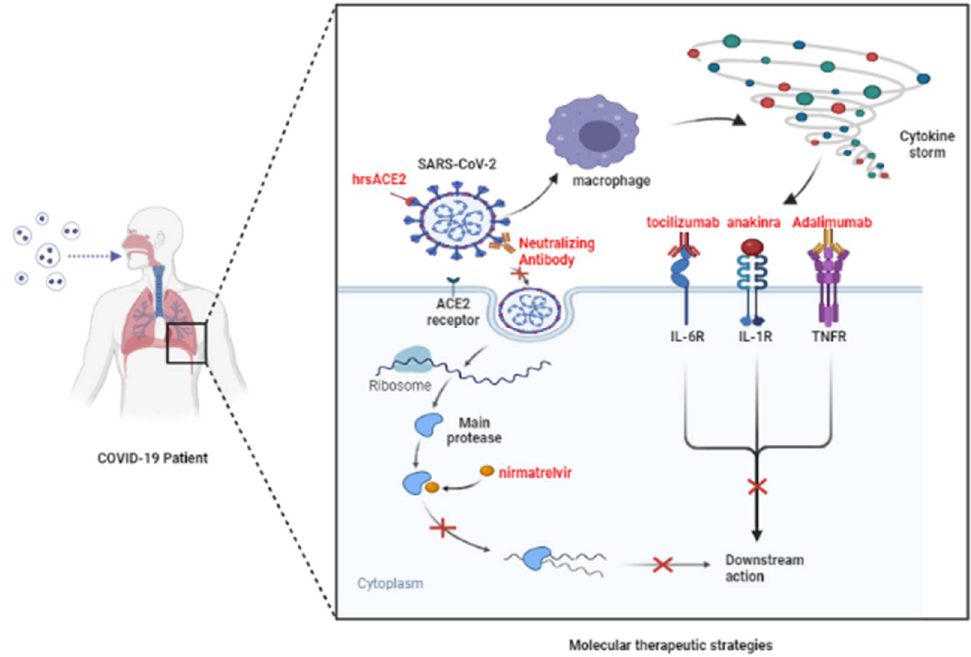
Figure 2. Potential molecular therapeutic mechanisms. SARS-CoV-2 can enter cells and replicate proteins by binding to ACE2 receptors. In addition, the virus in the alveoli also stimulates the immune system to produce a cytokine storm, which binds to receptors. It does this by blocking the viral S protein and the ACE2 receptor, or by inhibiting the activity of the main protease, inhibiting cytokine receptors and other strategies, and then producing an antiviral effect. ( Adapted from “COVID-19 Drug Mechanism of Action (Layout)”, by BioRender.com (2022). Retrieved from https://app.biorender.com/biorender-templates ( accessed on 28 July 2022)